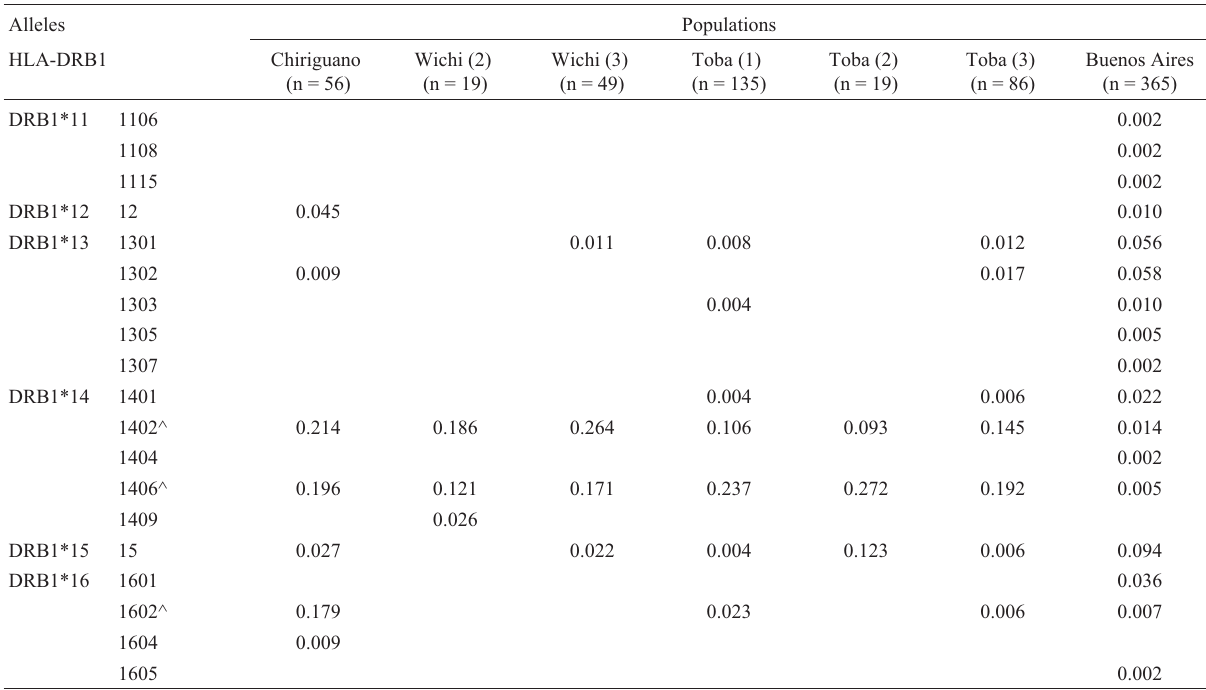
^: Most frequent alleles in Amerindian populations. For references, see Table 2.